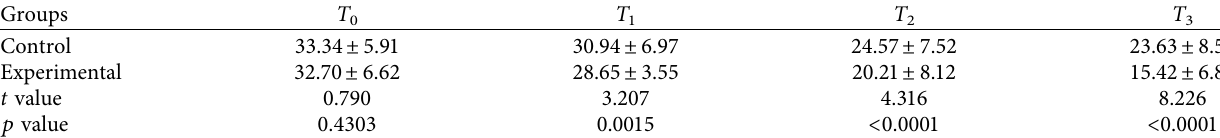
Table 3: The horizontal comparison of sST2 between two groups at different time points ( x ± S , μ g/L).